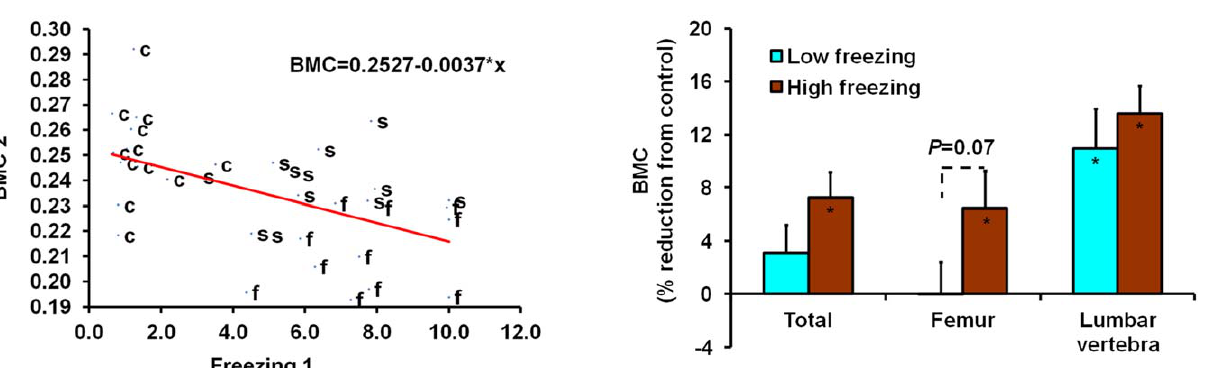
Figure 6. Regression using total body BMC as the dependent variable and freezing time as the independent variable. ‘‘BMC 2’’ refers to the total body BMC (g) at week 2, and ‘‘Freezing 1’’ the freezing time (sec) at week 1. s=electric shocks alone, f=electric shocks plus FG-7142 injection, c=control. R 2 =0.261, N=35, P , 0.01.